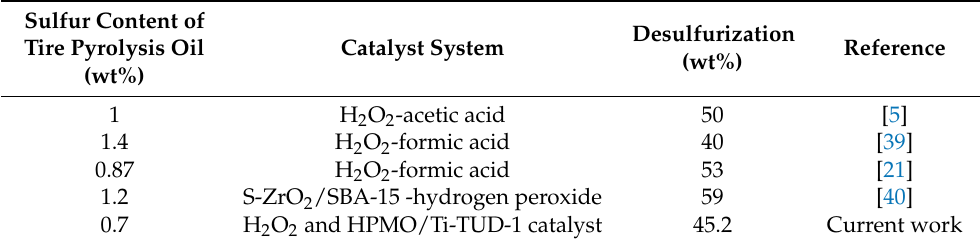
Figure 9. Three-dimensional response plots: ( a ) effects of catalyst amount (wt%) and O/S (molar ratio) on sulfur removal, ( b ) effects of catalyst amount (wt%) and temperature (°C) on sulfur removal, and ( c ) effects of temperature (°C) and O/S (molar ratio) on sulfur removal. Table 4. Comparison of HPMo/Ti-TUD-1 catalyst for ODS of tire pyrolysis oil with other reported catalysts. Sulfur Content of Tire Pyrolysis Oil (wt%)